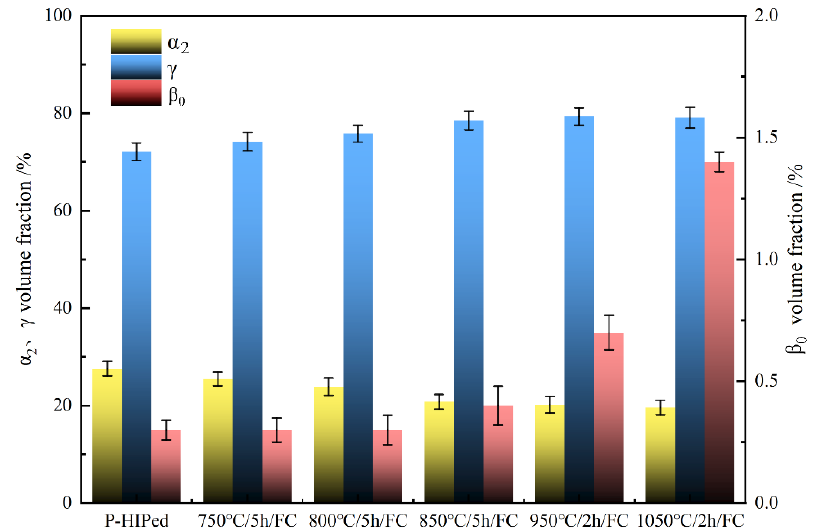
Figure 4. The volume fractions of phases after different exposure treatments.